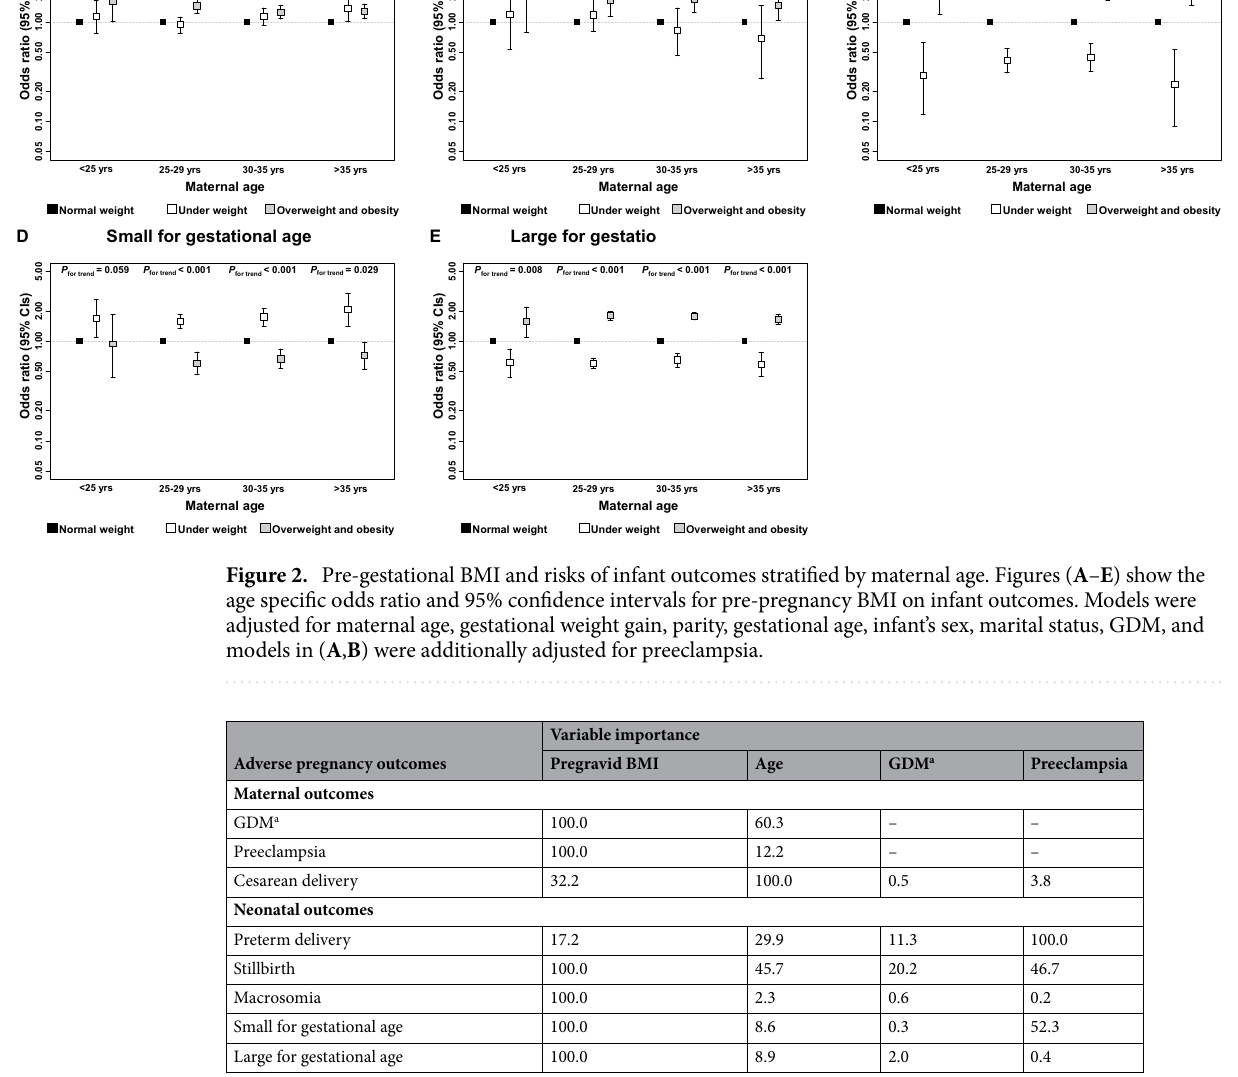
Table 4. Variable importance using Gradient Boosting Machine. Gradient Boosting Machine (GBM) is one of the statistical machine learning methods with the best prediction accuracy proposed by Friedman (2001) 36 . The variable importance is a measure expressed in a relative scale, when most influence variable for adverse pregnancy outcome is set to 10. a Gestational diabetes